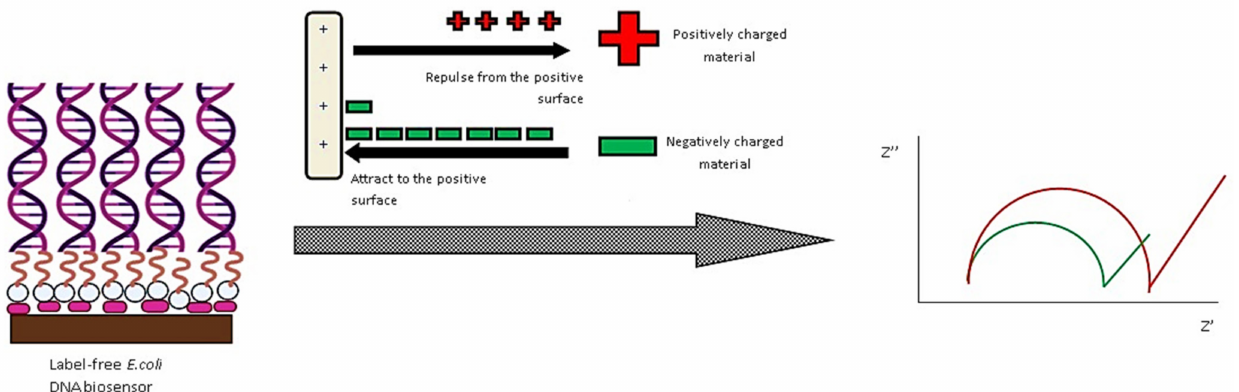
Figure 6. Schematic procedure for label free detection of E. coli by DNA attached-hollow silica NPs. Reprinted from Ref. [92].